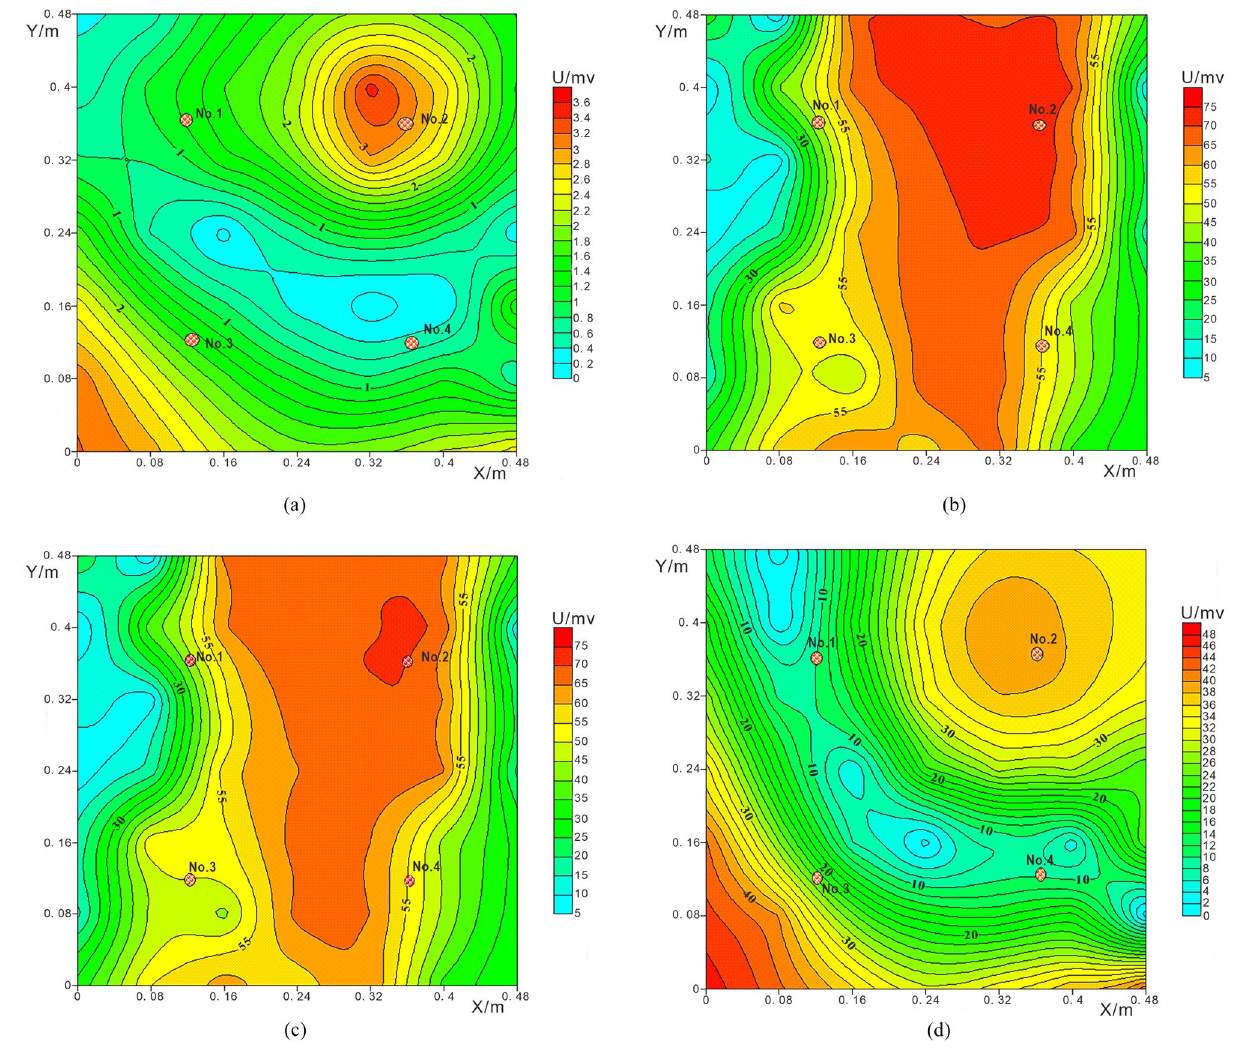
Figure 8. Leakage field potential diagram of soil layer: ( a ) Background electric field of soil layer; ( b ) Potential distribution of soil layer after 1 h of leakage; ( c ) Potential distribution of soil layer after 2 h of leakage; ( d ) Potential distribution of soil layer after closing the injection tube for 30